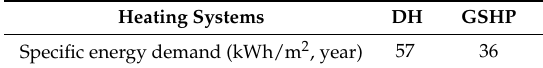
Table 5. Specific energy demand for the different system variations without solar energy system.